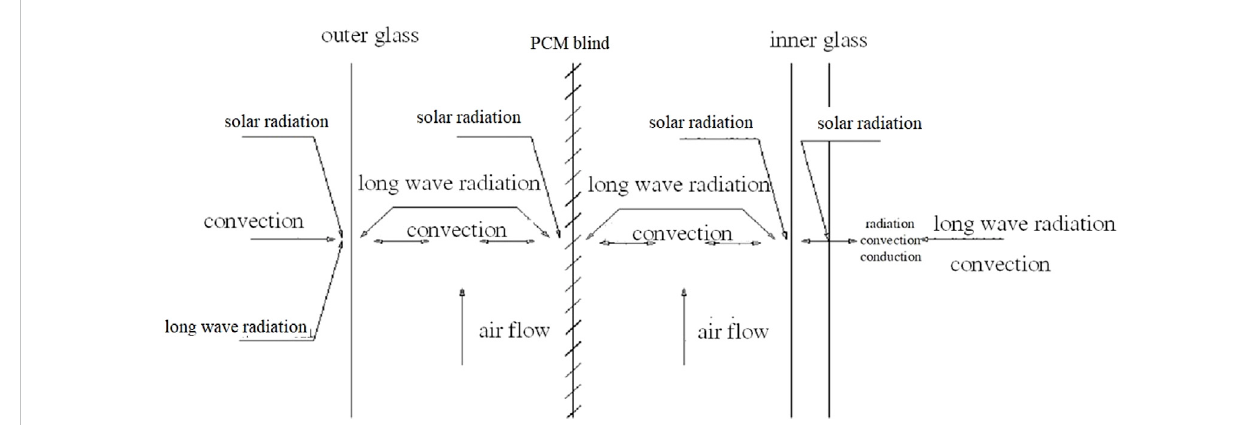
FIGURE 1 Heat transfer process of the integrated PCM blind and DSF system.